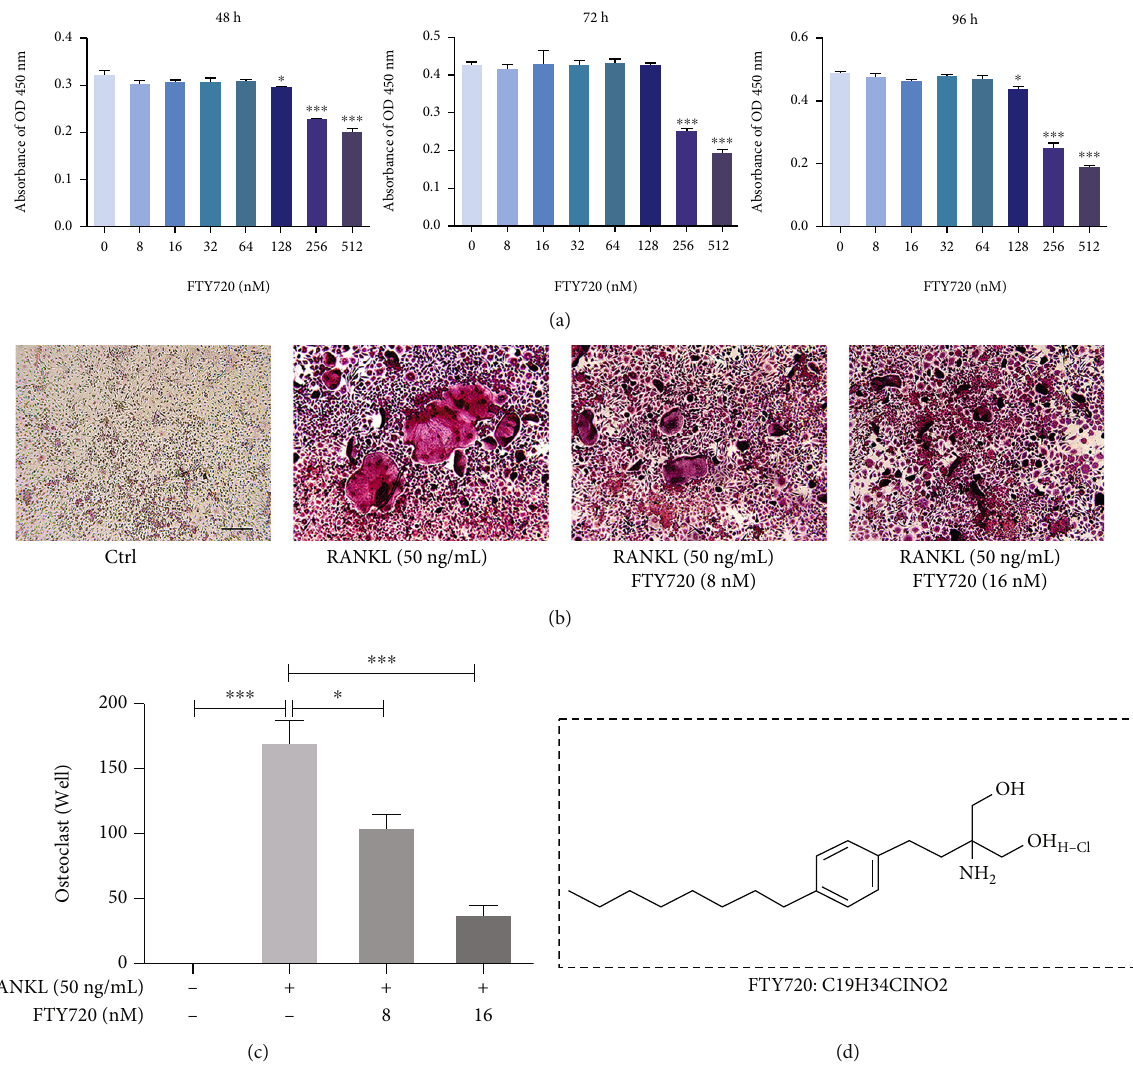
Figure 1: FTY720 inhibits receptor activator of NF- κ B ligand- (RANKL-) induced osteoclastogenesis without cytotoxicity. (a) The cell counting kit-8 (CCK-8) assay was used to detect the OD (optical density) value re fl ecting the level of cell proliferation under treatment with FTY720 for di ff erent times (48 h, 72h, and 96h) and at di ff erent concentrations (8-512nM) ( n = 3 ). (b) Tartrate-resistant acid phosphatase (TRAP) staining of osteoclasts (OCs) in the presence or absence of FTY720. Scale bar: 200 μ m. (c) Quantitative analysis of TRAP-positive OCs with three or more nuclei ( n = 3 ). (d) The molecular structure of FTY720. Data are expressed as the mean ± SEM . ∗ P < 0 : 05 , ∗∗ P < 0 : 01 , ∗∗∗ P < 0 : 001 by one-way ANOVA with Tukey ’ s post hoc test (a,